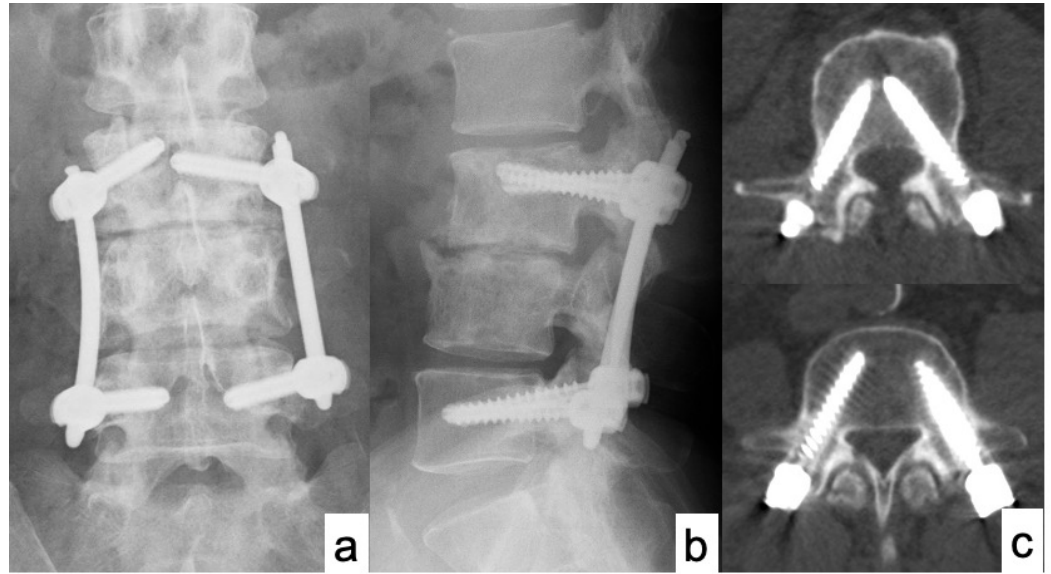
Figure 2. X-ray and CT scan of case No. 14 immediately after surgery. ( a ) X-ray of AP view; ( b ) X-ray of lateral view; and ( c ) Axial views of CT scan showed accurate PPS